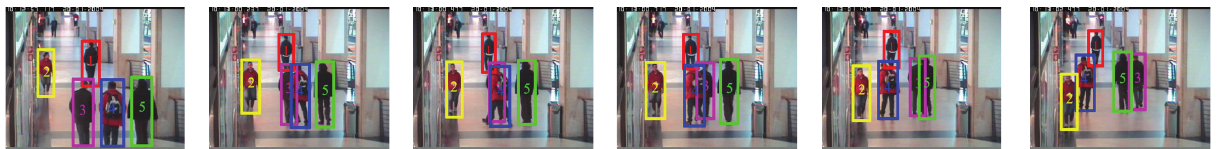
Figure 8: The typical results of Threepastshop2 (Frame: 375, 453, 459, 465, 484, and 509).